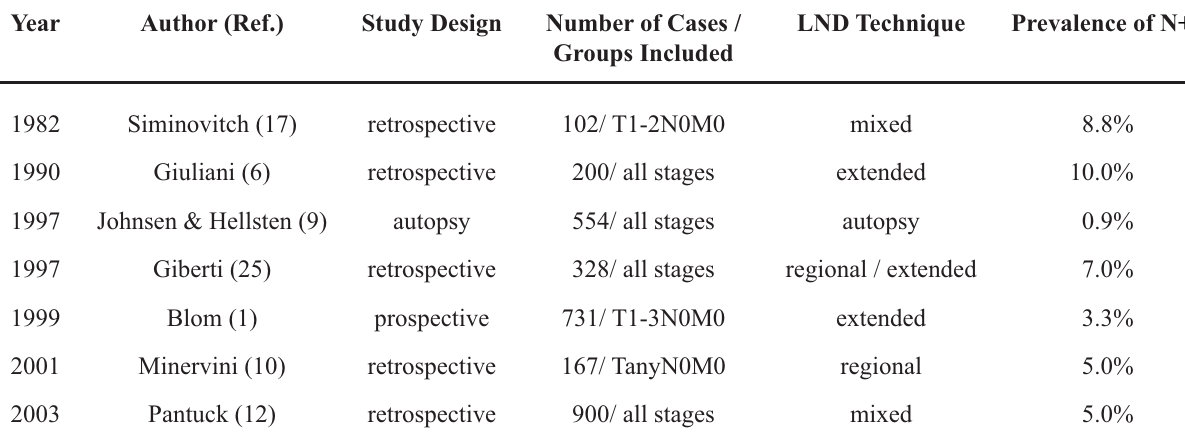
LND = lymph node dissection; N+ = Node positive disease.